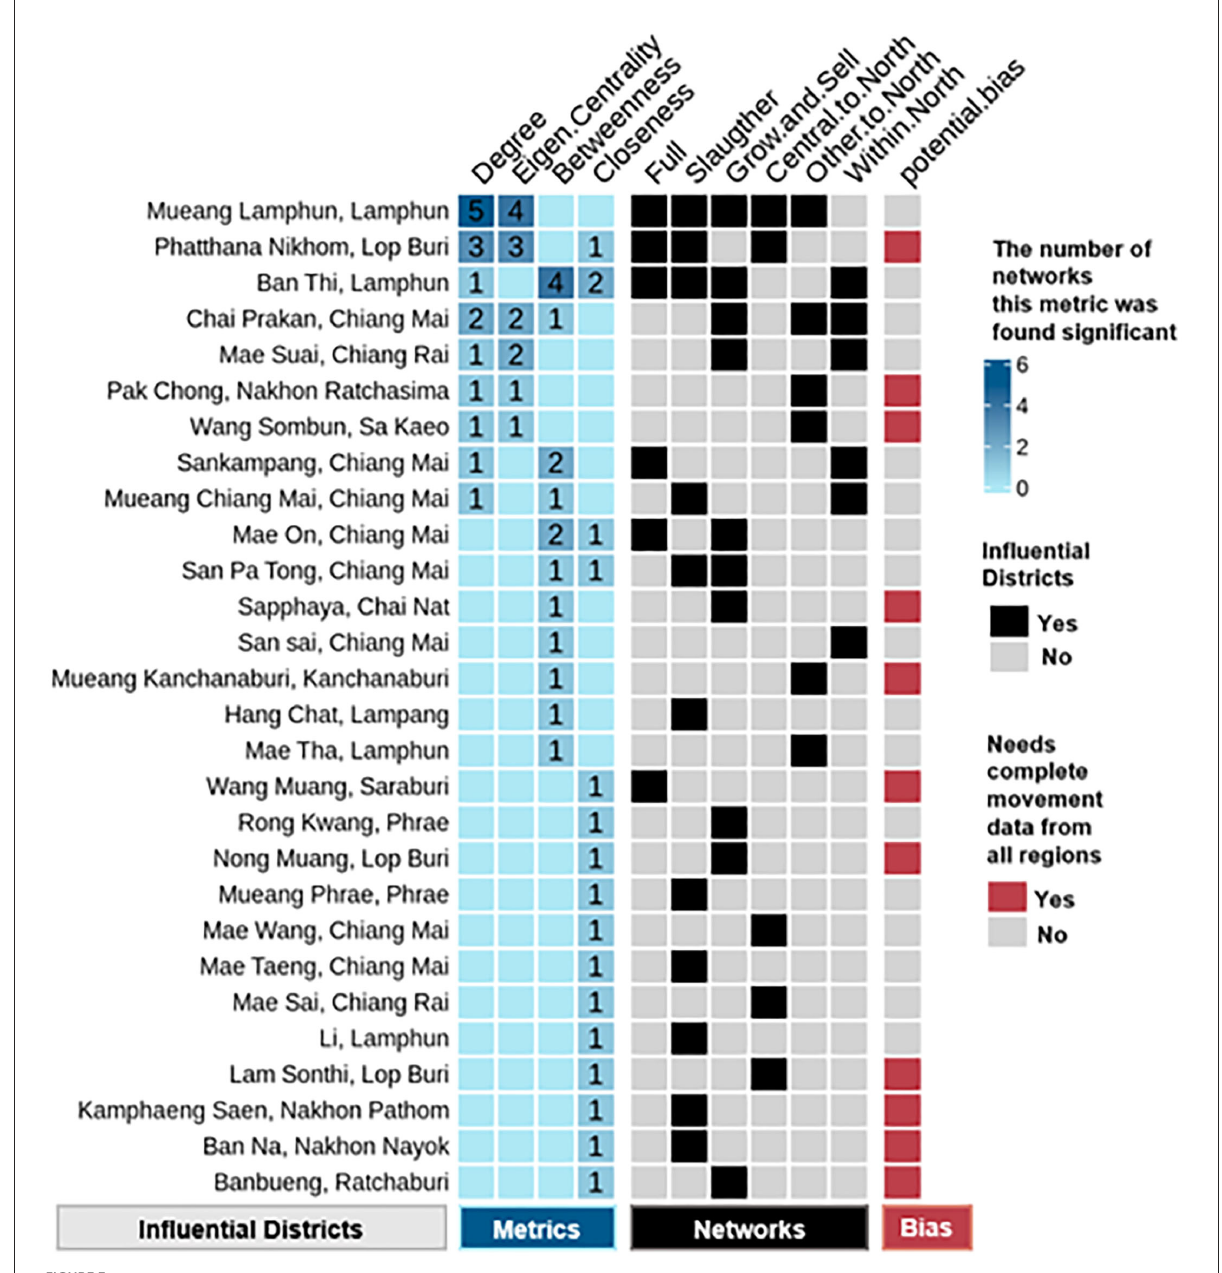
FIGURE3 Influential districts are identified through social network analysis. The heatmap has three or four sections: districts, metrics, networks, and bias. The district section shows a complete list of districts identified as their network metrics exceeded the network mean plus two standard deviations of the metrics in corresponding networks. The metric section shows which of the four metrics were significant and how many networks were associated with these metrics. The network section shows which of the six networks the district had significant metrics. The bias section shows if the selected district was from the northern region, or complete movement data are needed to reevaluate its